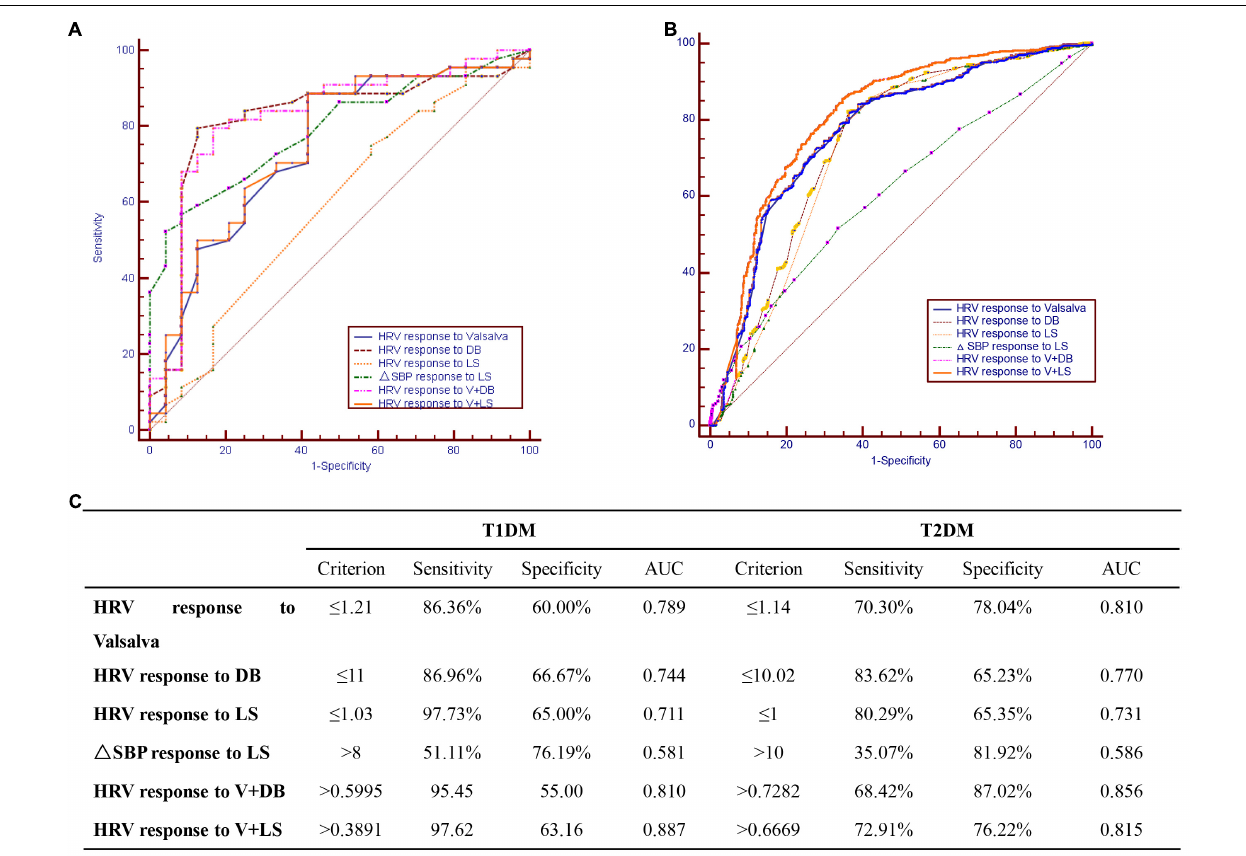
FIGURE 1 | Cardiovascular autonomic neuropathy (CAN) diagnostic tests in (A) T1DM, (B) T2DM, and (C) combination of CAN diagnosis tests in T1DM and